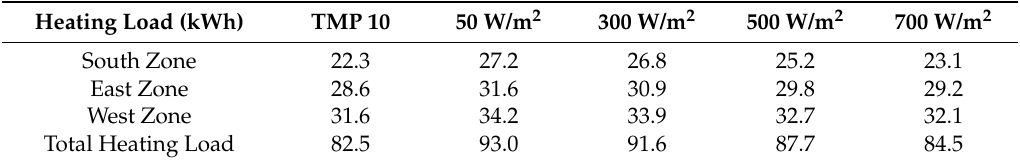
Table 6. Heating load of electrochromic glass on a typical winter day by controlling conditions.